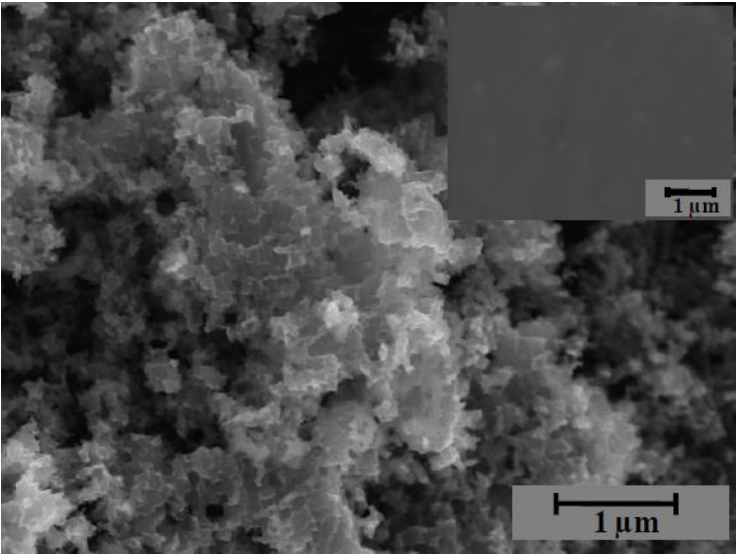
Figure 1. FESEM image of a HCl-etched nanostructured aluminum alloy surface; the inset shows the image of a clean aluminum alloy surface before etching.